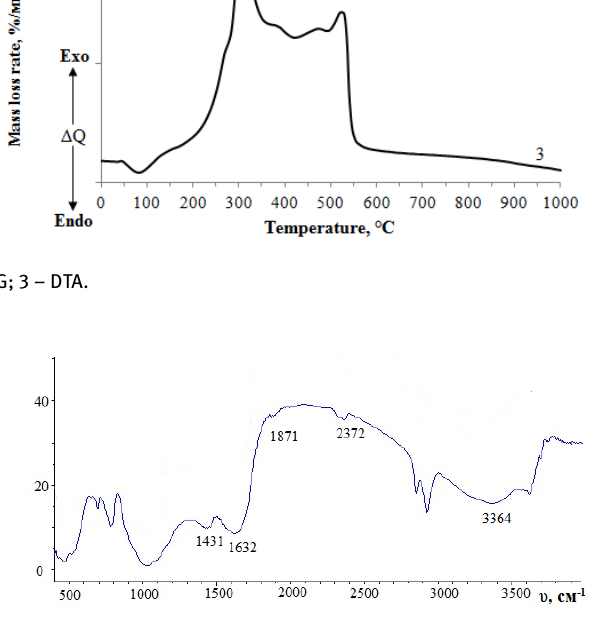
Figure 3: IR-spectra of humic